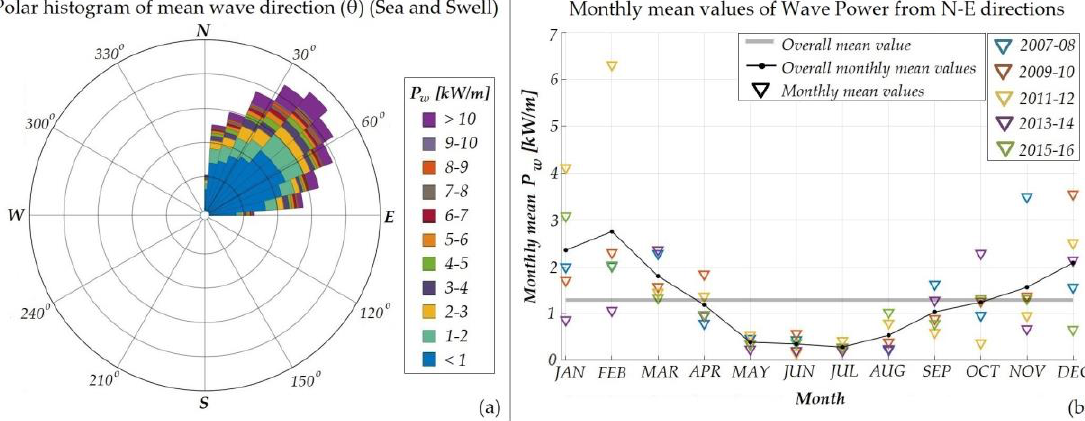
Figure 14. Polar histogram and monthly mean values of the incident wave power.